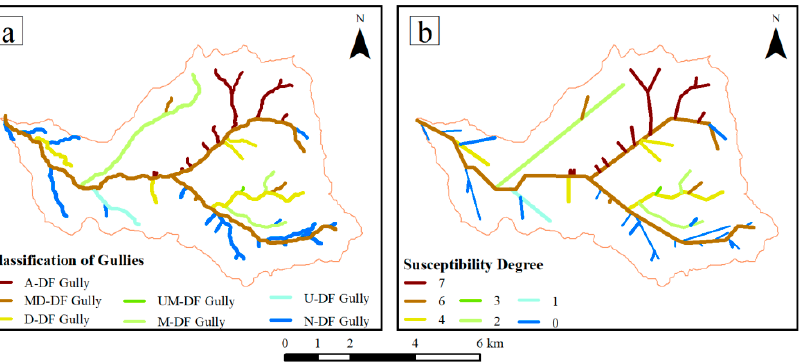
Figure 10. Gully classification and different susceptibility degrees. ( a ) Overlay display of the different gully levels and their classification; ( b ) Susceptibility degree topological diagram of debris flow gullies. We have not obtained UD-DF gullies (Digital ID = 5) in the JJG, but only seven of the eight categories were successfully interpreted. Table 3. Statistics of different debris flow gullies in the JJG.